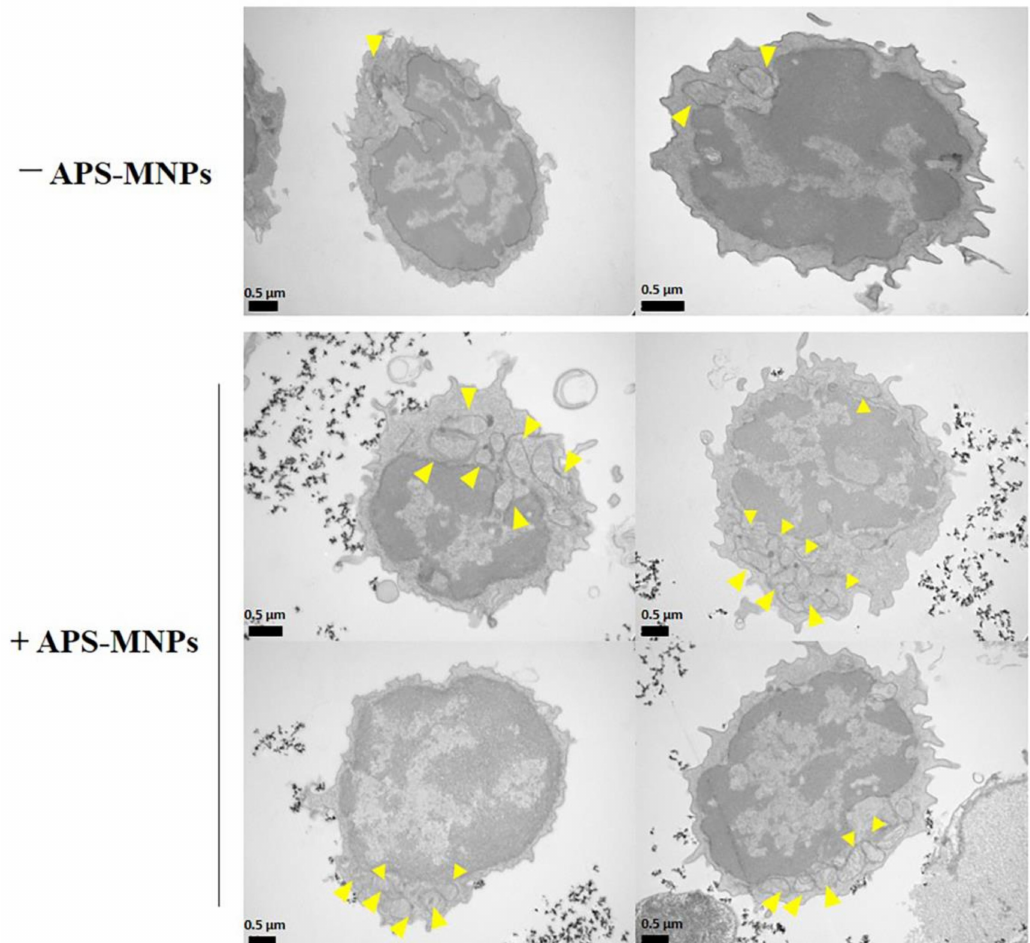
Figure 2. MNP treatment increases the presence of mitochondria in naïve T cells. Representative images obtained by transmission electronic microscopy from murine naïve T cells with MNPs. Arrowheads indicate the mitochondria within the cells. TEM methodology is described in